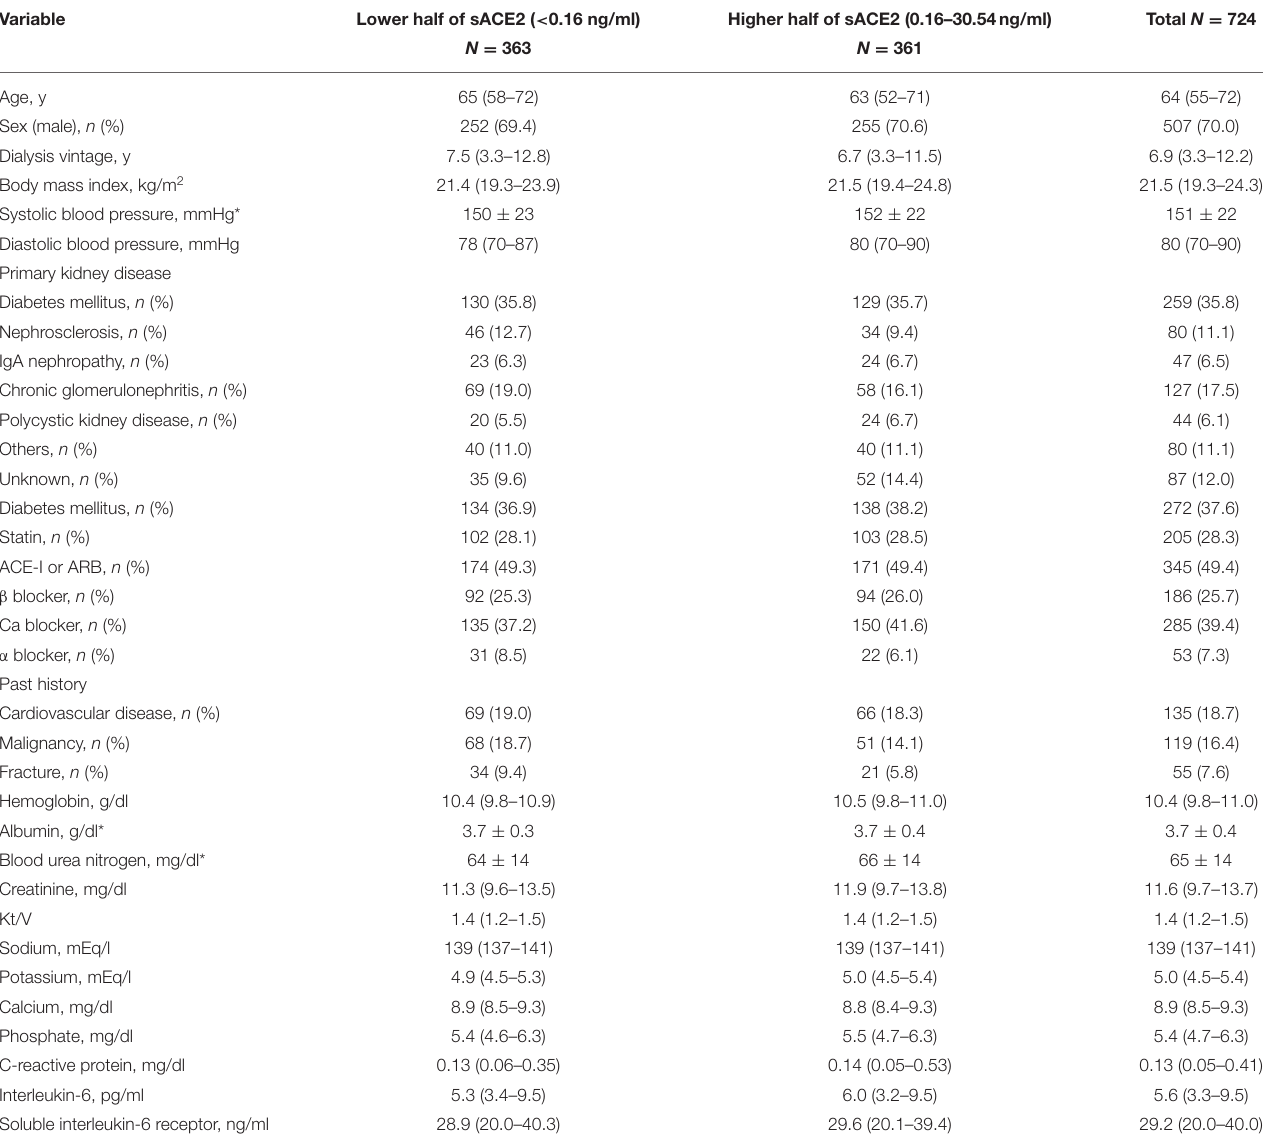
TABLE 1 | Clinical characteristics of patients undergoing hemodialysis by sACE2 levels.